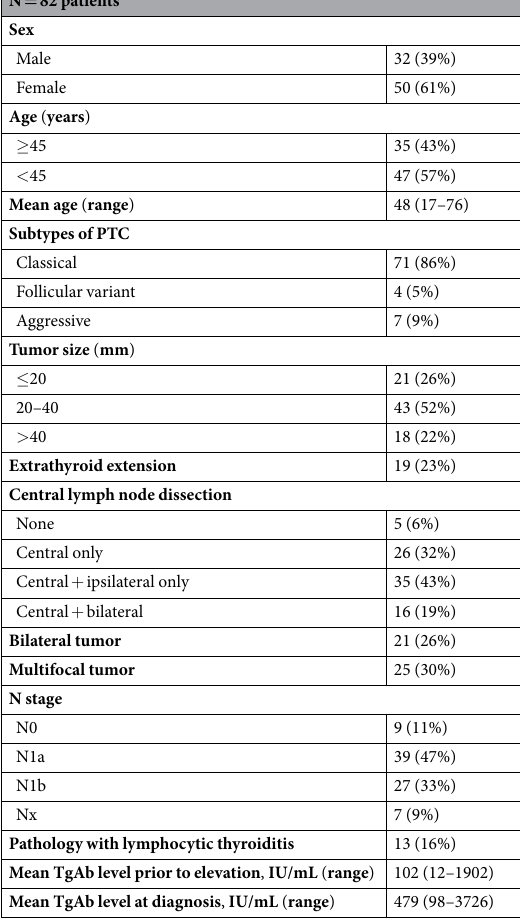
Table 1. Patients’